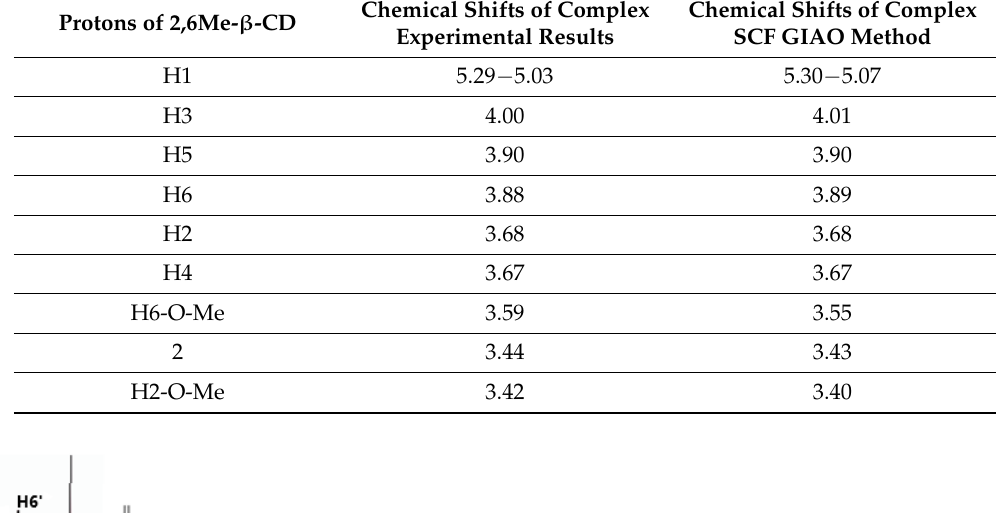
Figure 2. The 1 H NMR of ( A ) 2,6Me- β -CD ( B ) complex of QUE with 2,6Me- β -CD. The spectra were obtained at 25 °C in D 2 O.